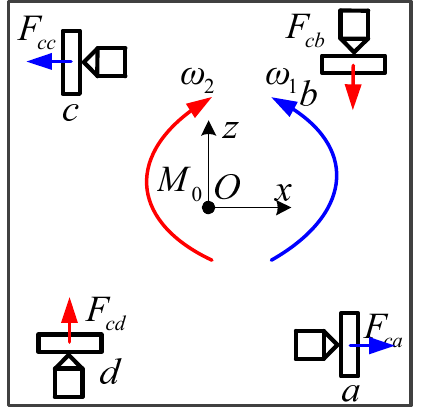
18 of 28 group b moves in the negative direction of the z -axis, the payload will be forced to rotate clockwise around the point O , and if the hook in the positive direction of the z -axis, the payload will to rotate counterclockwise, as shown in Figure 19. 1 ω ( d ) Figure 19. Schematic diagram of the direction of the capture hook and the direction of rotation for the payload. ( a ) Group c capture hooks in the negative x -axis; ( b ) group c capture hooks in the pos- itive x -axis; ( c ) group b capture hooks in the negative z-axis; ( d ) group d capture hooks in the positive z-axis. According to the influence of the movement direction of the capture hooks on the rotation direction of the payload during the capture process, it can be concluded that: For a set of active and passive catching lock assemblies where the movement direction of the capture hook is perpendicular to the axis of the catching frame, two directions can be se- lected, one of which will force the payload to rotate clockwise, and the other will force the payload to rotate counterclockwise. Since the movement of four sets of capture hooks are different, there are = K total movement arrangements. Therefore, to achieve the purpose of adjusting the attitude of the payload during the capture process, two capture hooks on a diagonal line are selected to rotate the payload clockwise, and two capture hooks on the other diagonal line to rotate the payload counterclockwise. Thus, group a